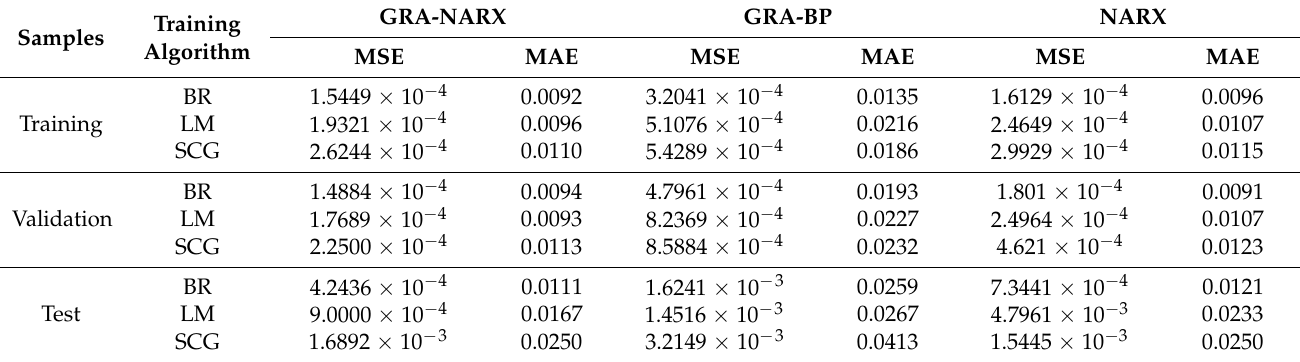
Table 5. The MSE and MAE values for the three models with different training algorithms in the training, validation, and test periods.